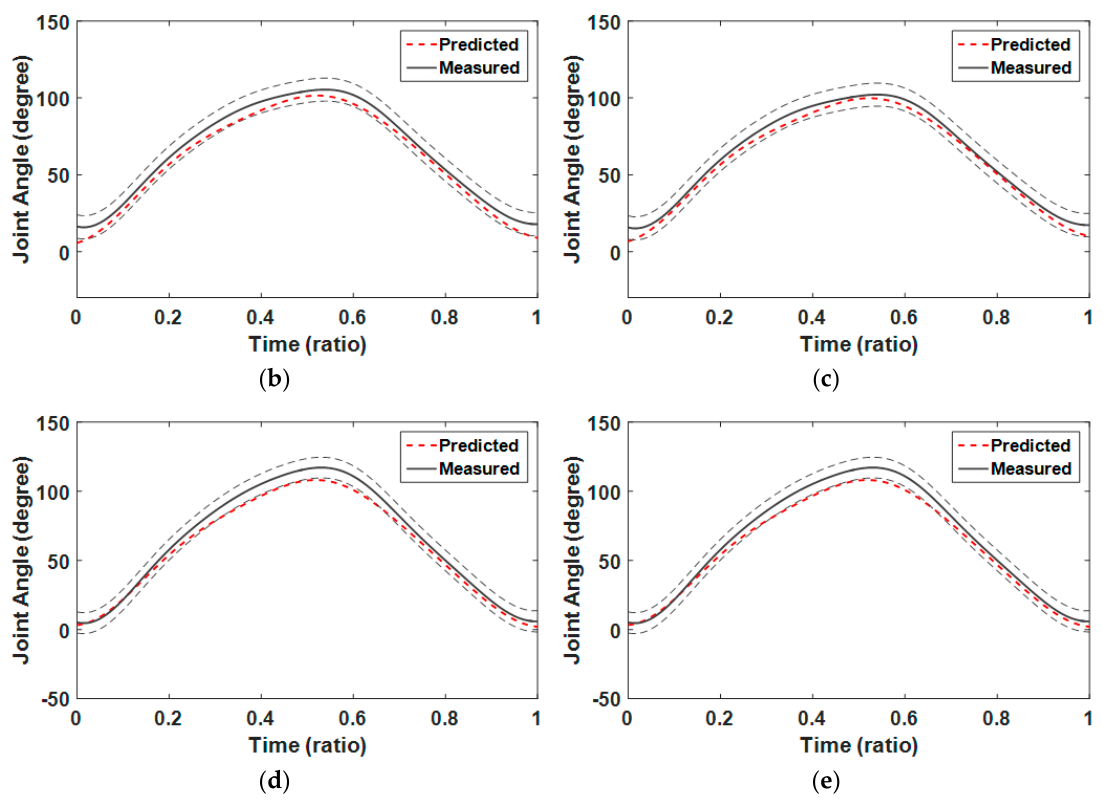
Figure 9. Comparison of squat motion generated using GPR algorithm with average motion determined in the case where foot position was 0.07 h and guide angle was 5° from barbell bar center: flexion/extension of ( a ) pelvis–thorax; ( b ) left hip; ( c ) right hip; ( d ) left knee; and ( e ) right knee. Table 6. NRMSEs of captured and synthesized joint angles.